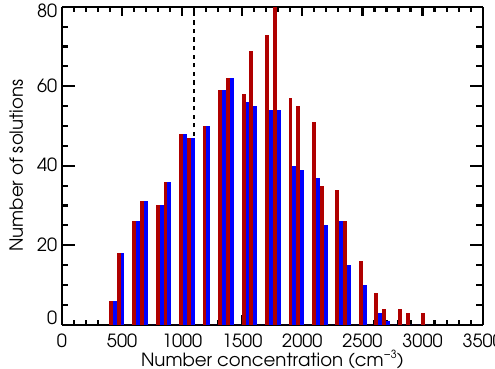
Figure 6. Histograms showing the total number concentration value for all solutions in the gridded LUT (i.e., without interpolation) that match the backscatter and extinction coefficients of Case 1 within measurement errors of 5% for backscatter and 20% for extinction. The total number concentration value for Case 1 is marked with a dashed line. Red histogram bars show solutions from the full grid- ded LUT. Blue histogram bars show solutions from the modified LUT, which excludes size distributions that have a significant con- tribution from particles of smaller than 50nm